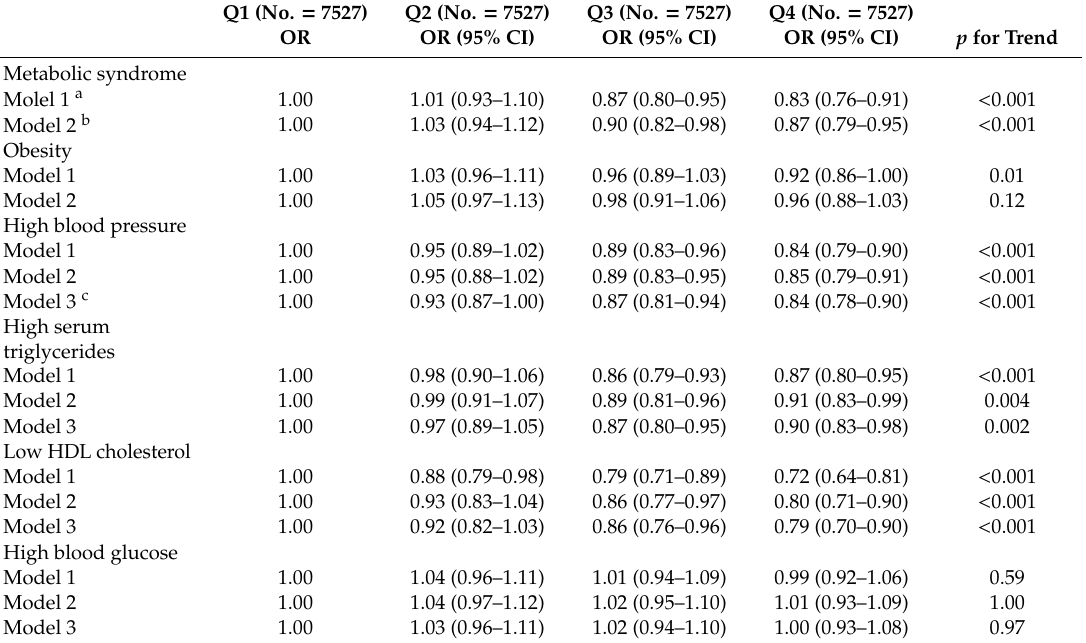
Table 5. Associations of Factor 3 (saturated fatty acids, calcium and vitamin B2 pattern) scores with metabolic syndrome and its